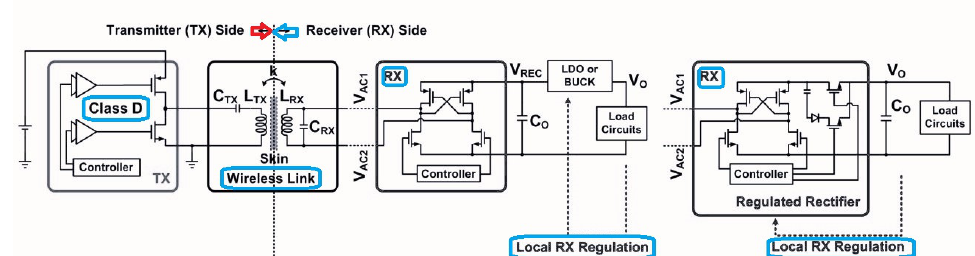
Figure 21. The overall presented Tx and Rx structures based on the CMOS